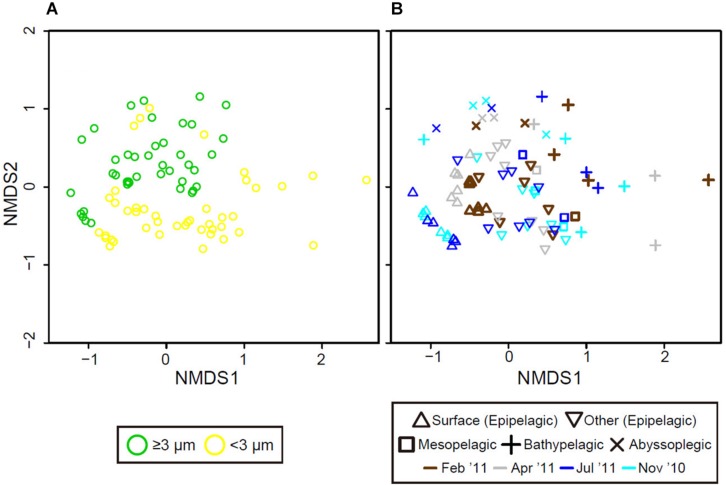
Grouping of eukaryotic phytoplankton communities based on non-metric multidimensional scaling (nMDS) according to community similarity (Bray–Curtis distance), differentiated by (A) size fraction (color), (B) water depth (shape), and month (color).